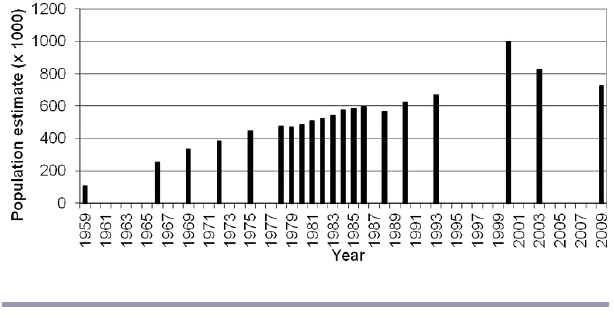
Fig. 2 . Population estimates of the Taimyr wild reindeer herd 1959-2009. Estimates for 2003 and 2009 were based on aerial surveys combined with expert opinion because coverage was incomplete.